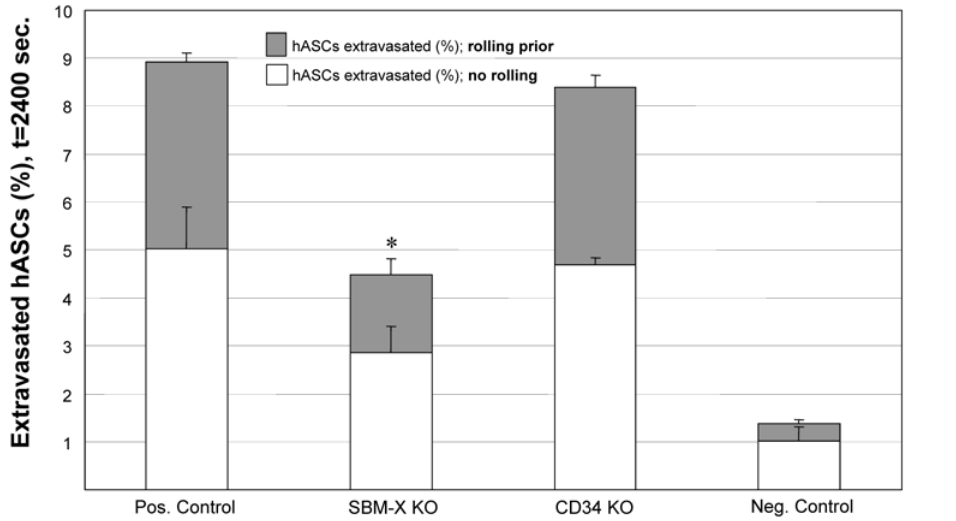
Figure 7. The ABM generated the new hypothesis that selectin-mediated rolling via an unknown adhesion molecule was critical to hASC trafficking. Knockouts of a theorized adhesion molecule, termed SBM-X, significantly reduced hASC extravasation versus positive control (no knockouts). A high degree of hASCs rolled prior to extravasation into ischemic tissue, as compared to the negative controls (non-ischemic healthy tissue). Of note, the elimination of SBM-X from rule-sets also reduced the number of extravasated hASCs that did not roll prior to firm adhesion. Reported are mean values + standard deviation (n=5–9). Significance asserted at p , 0.05.